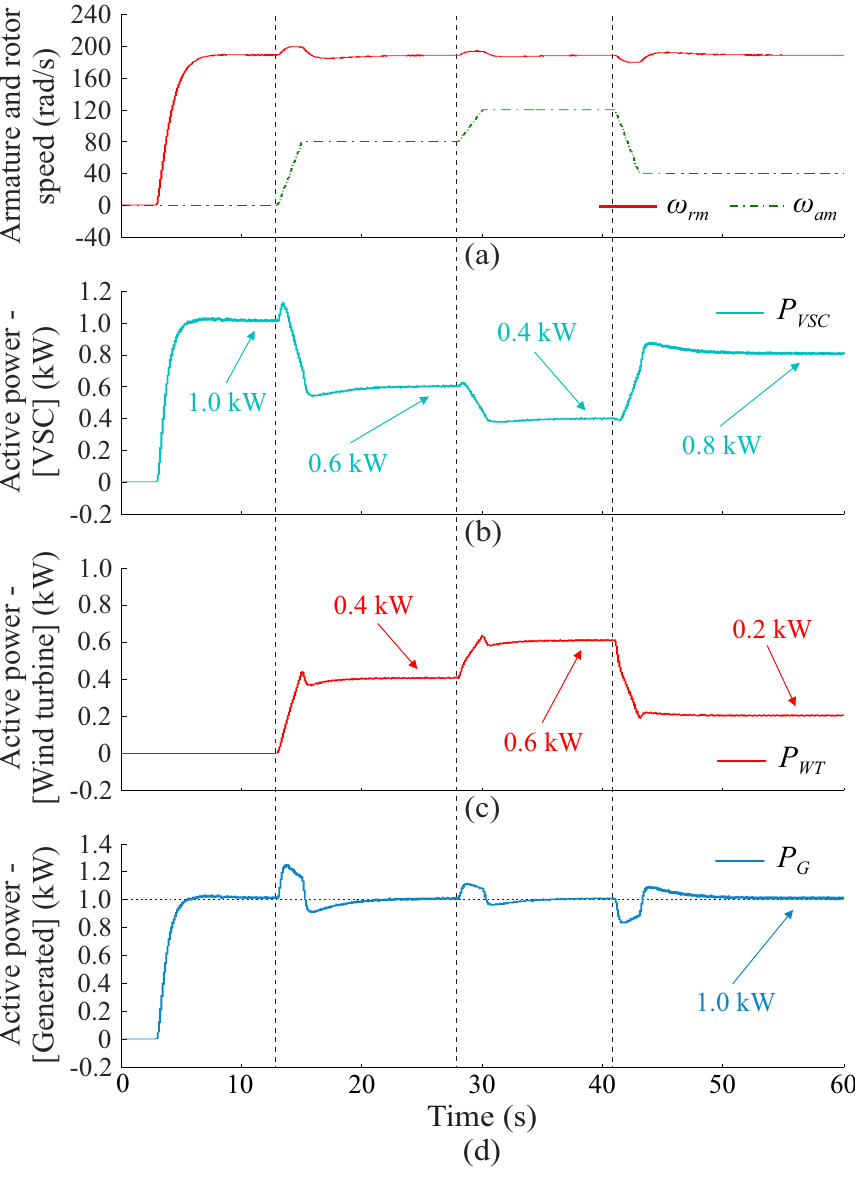
Figure 17. Power-sharing in the EFR-based system: ( a ) armature end rotor speed, ( b ) VSC active power, ( c ) wind turbine active power and ( d ) generated active